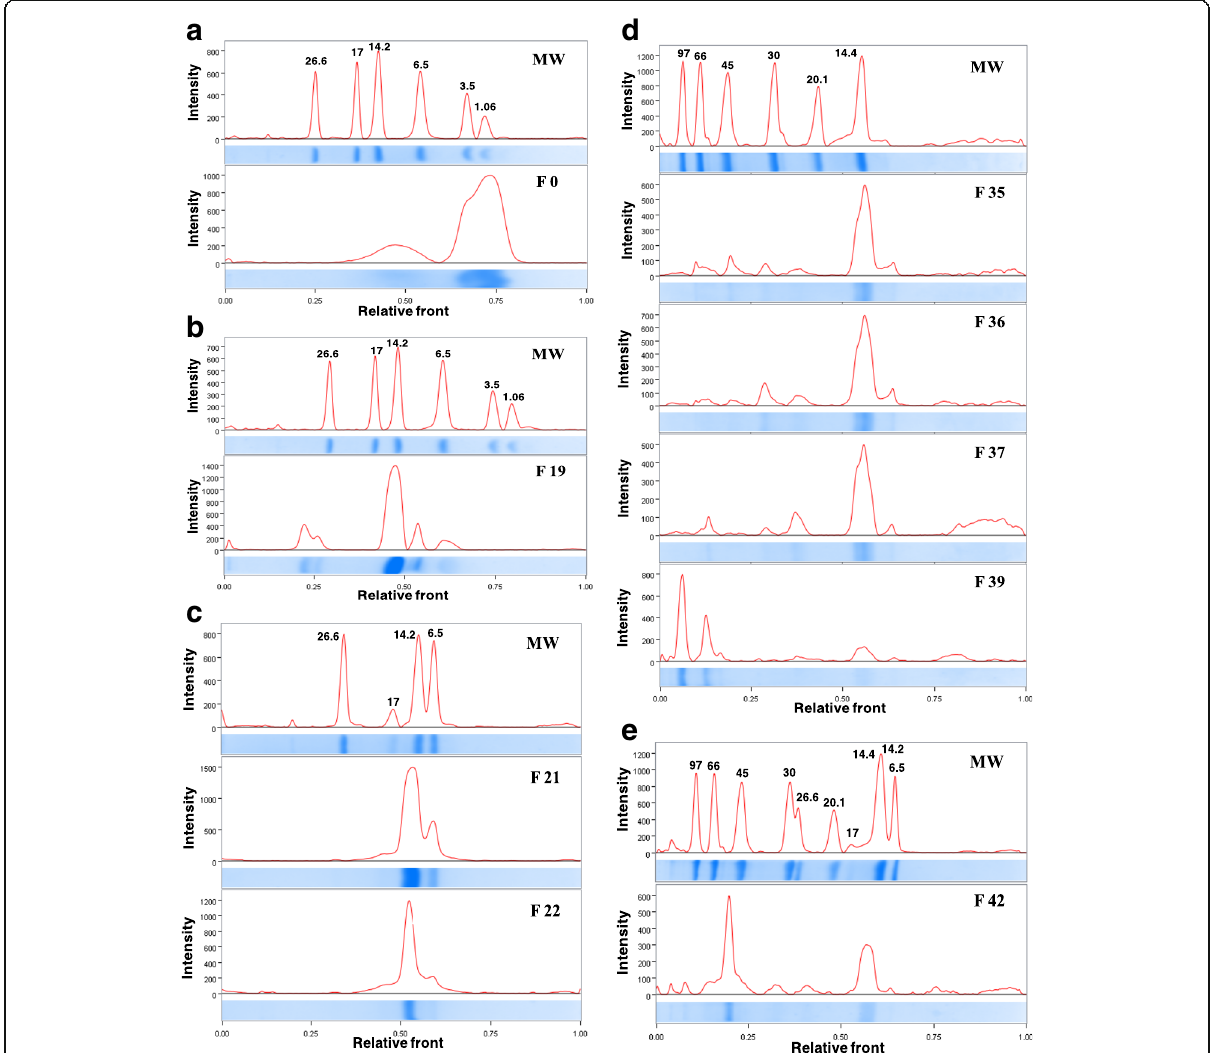
Fig. 2 Densitometric analyses of the SDS-PAGE profiles of RP-FPLC fractions. (a) Fraction 0, (b) Fraction 19, (c) Fractions 21 and 22, (d) Fractions 35, 36, 37 and 39 and (e) Fraction 42. MW: molecular weight. Absorbance at 302 nm and the graphic created by software Image Lab ™ ,